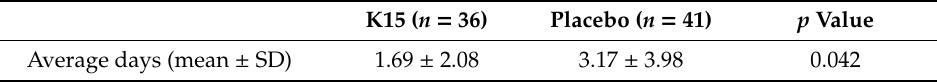
Table 4. The number of febrile days in children with a rare intake of other lactic acid bacteria.